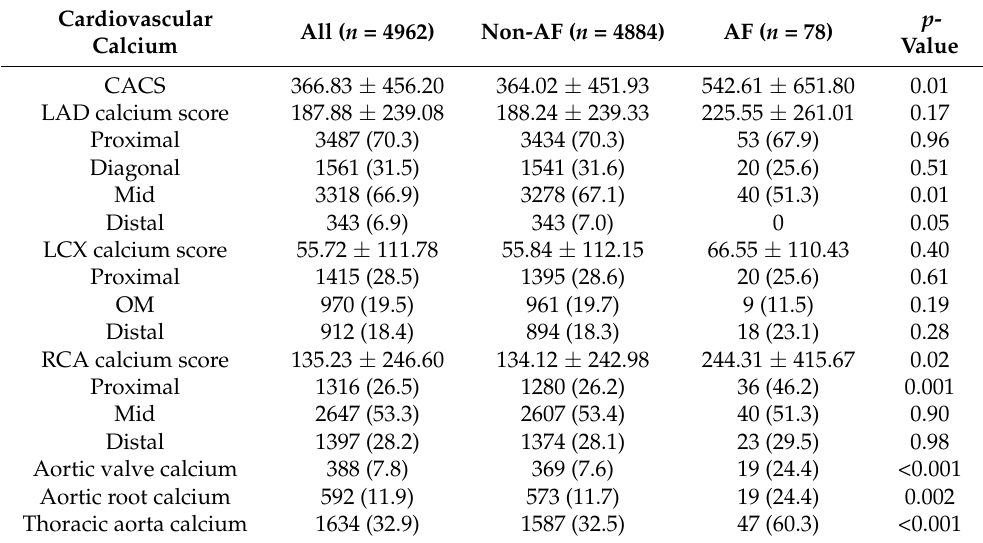
Table 4. Cardiovascular calcium distribution according to atrial fibrillation (CACS ≥ 100).